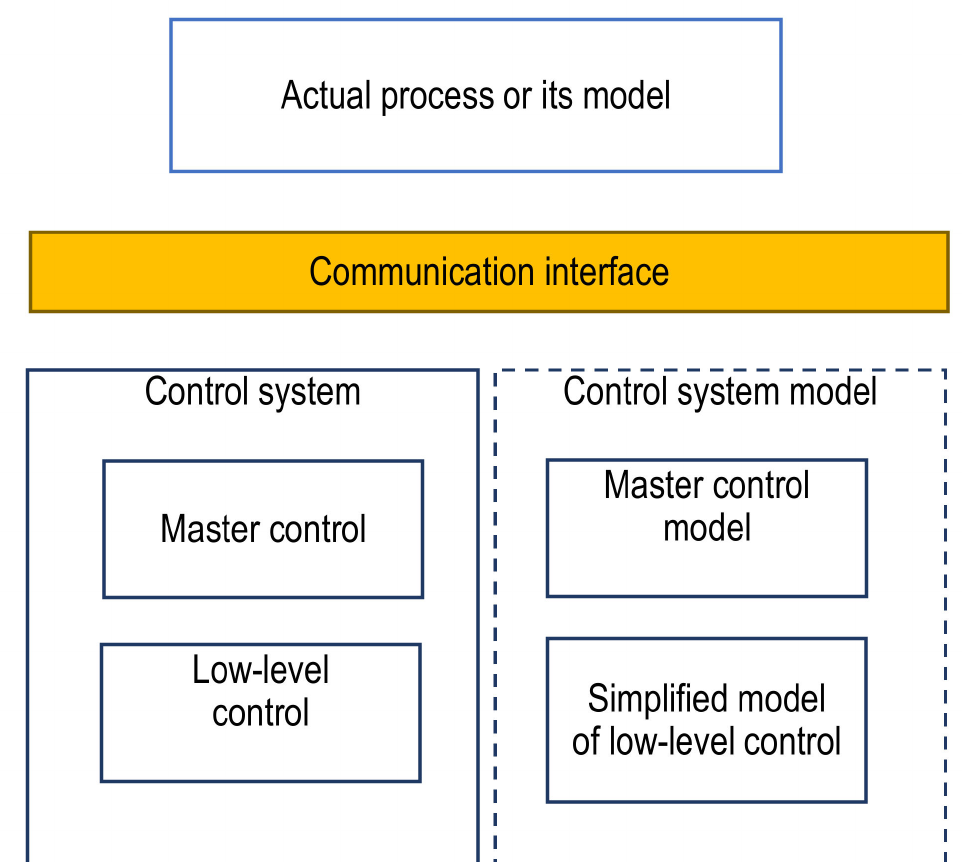
Figure 9. The existing control system and its simplifying model. Source: own